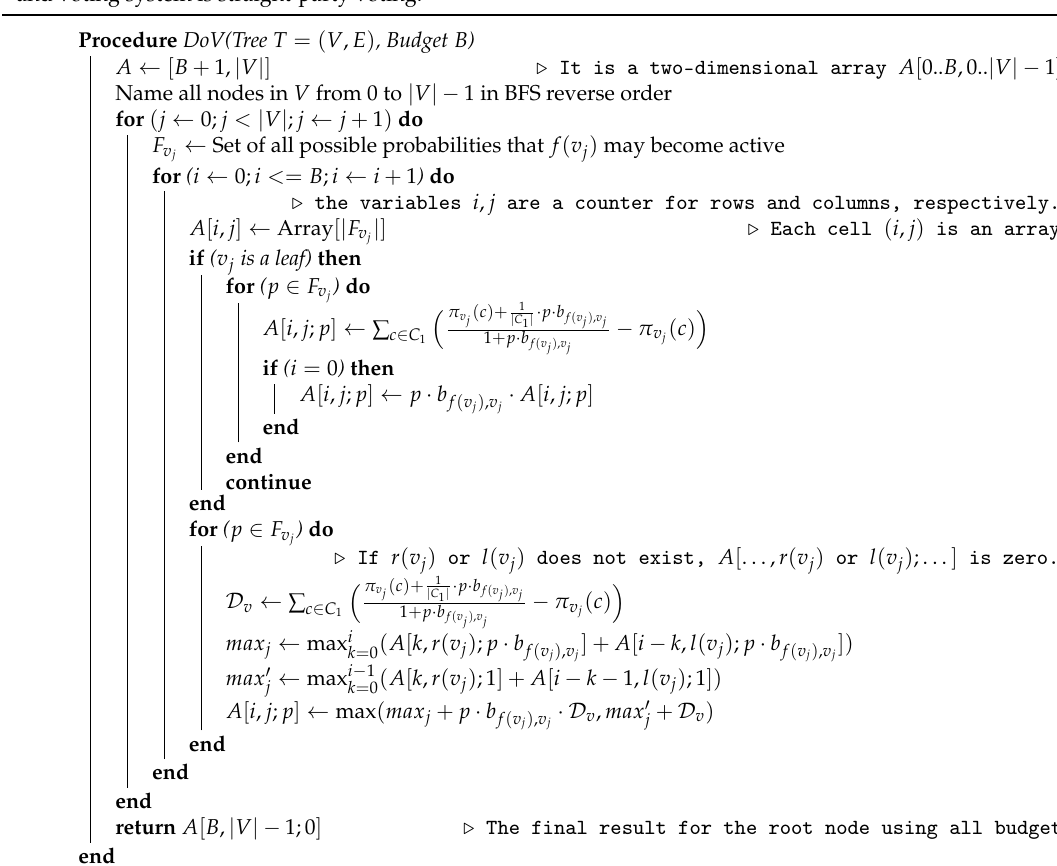
Algorithm 1 : Calculating maximum DoV c for e given tree T and budget B when the diffusion model is LTM and voting system is straight-party